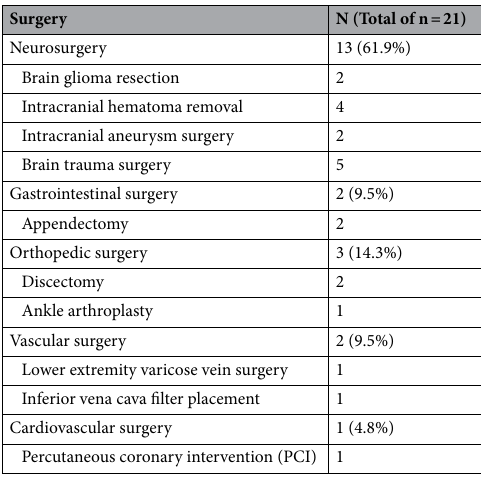
Table 1. Details of